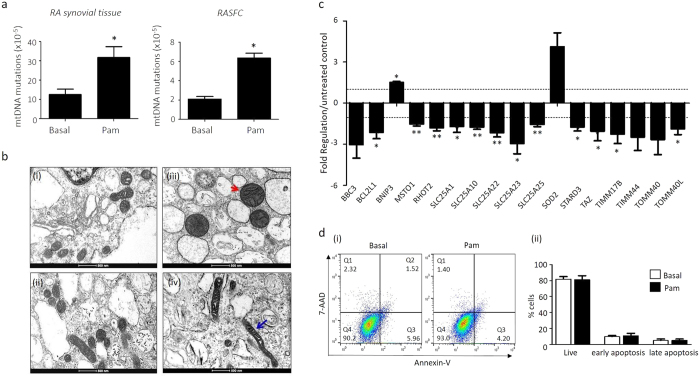
TLR2 activation induces mitochondrial mutations in RASFC in vitro.(a) Bar graphs representing increased mtDNA mutation frequency in RA ex vivo explants (n = 7) and RASFC (n = 6) in response to Pam3CSK4 (1 μg/ml) stimulation for 24 hrs. (b) Representative transmission microscopy images of RASFC mitochondria under basal or Pam3CSK4 (1 μg/ml) stimulated conditions. Regular shaped mitochondria are seen in resting cells, in contrast to larger more dense (red arrows) mitochondria and a higher frequency of elongated mitochondria (blue arrow). Scale bar represents 500 nm. (c) Bar graph demonstrating 17 genes dysregulated in response to 24 hr incubation with Pam3CSK4 (1 μg/mL) as assessed by RT2 PCR Profiler Microarray (n = 3). Dashed line represents no change (1). Data is expressed as up- or down-regulation compared to basal control. Data is normalised to housekeepers: β-Actin, B2M, GAPDH, HPRT1 and RPLP0. (d) (i) Representative scatter plots demonstrating Annexin-V/7-AAD double staining in RASFC in response to Pam3CSK4 (1 μg/ml) stimulation for 24 hrs and (ii) representative bar graphs showing percentage of live, early apoptotic and late apoptotic cells under basal control or Pam3CSK4 stimulated conditions (n = 3). Non-parametric data was analysed using Wilcoxin Signed Rank test and parametric data was analysed using paired t-test and is represented as Mean ± SEM, *p < 0.05, **p < 0.01 significantly different to control.